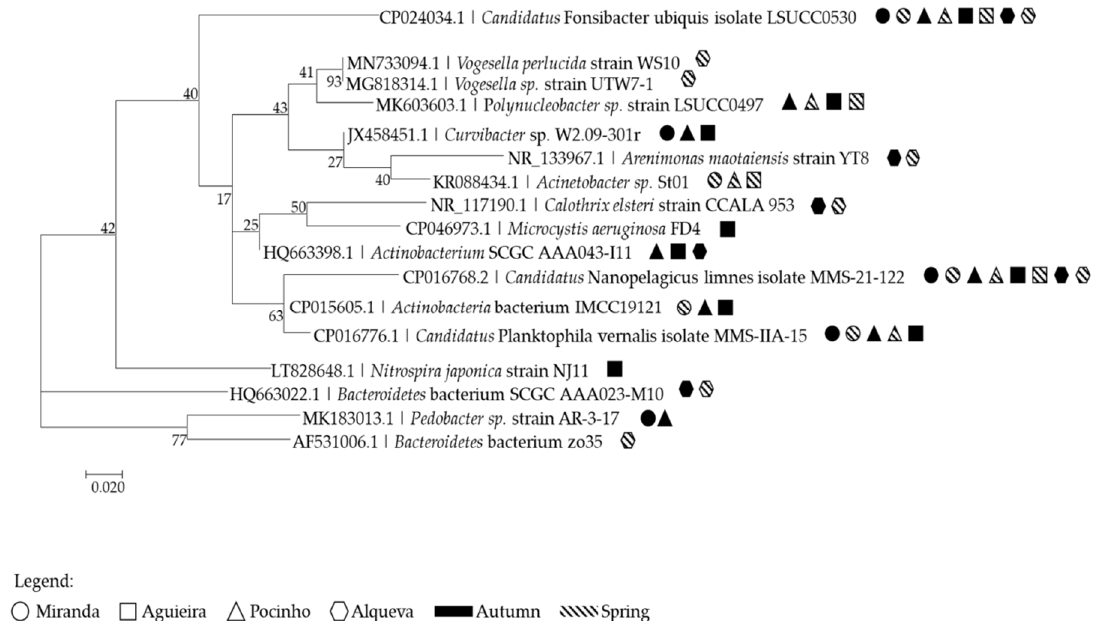
Figure 5. Phylogenetic 16S rRNA gene tree generated by maximum-likelihood analysis based in general time reversible model and gamma distributed with invariant sites (G + I), indicating the relationship of the strains collected in the present study. Bar—0.02 substitutions per 100 nucleotides. Symbols annotated the reservoir and season where the strain was